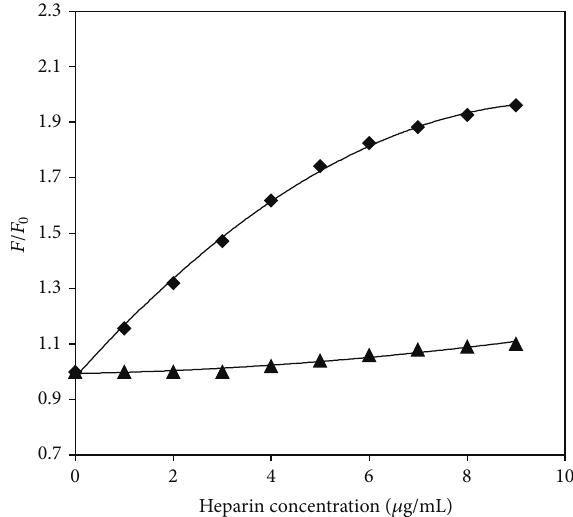
Figure 7: Plots of the luminescence enhancement ratio ( 𝐹/𝐹 0 ) of ( X ) [ Os(phen) 2 CO(4-phpy)](PF 6 ) 2 , and [ 󳵳 ][Os(bpy) 2 CO(4- phpy)](PF 6 ) 2 at 560nm in aqueous solution (1.2mg/100mL) versus heparin